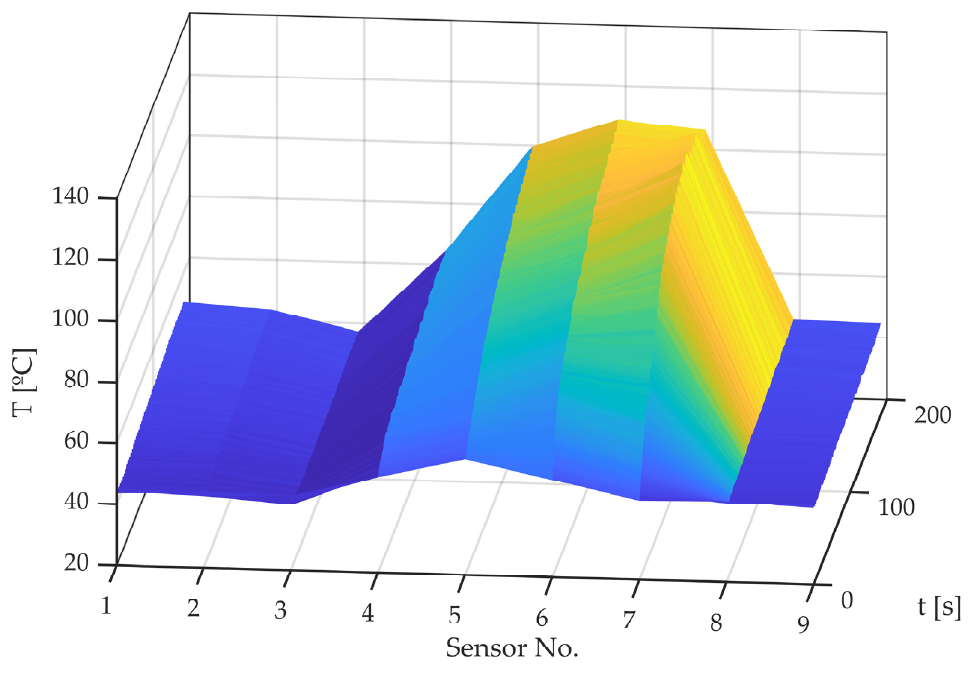
Figure 13. Measured temperatures for each sensor against